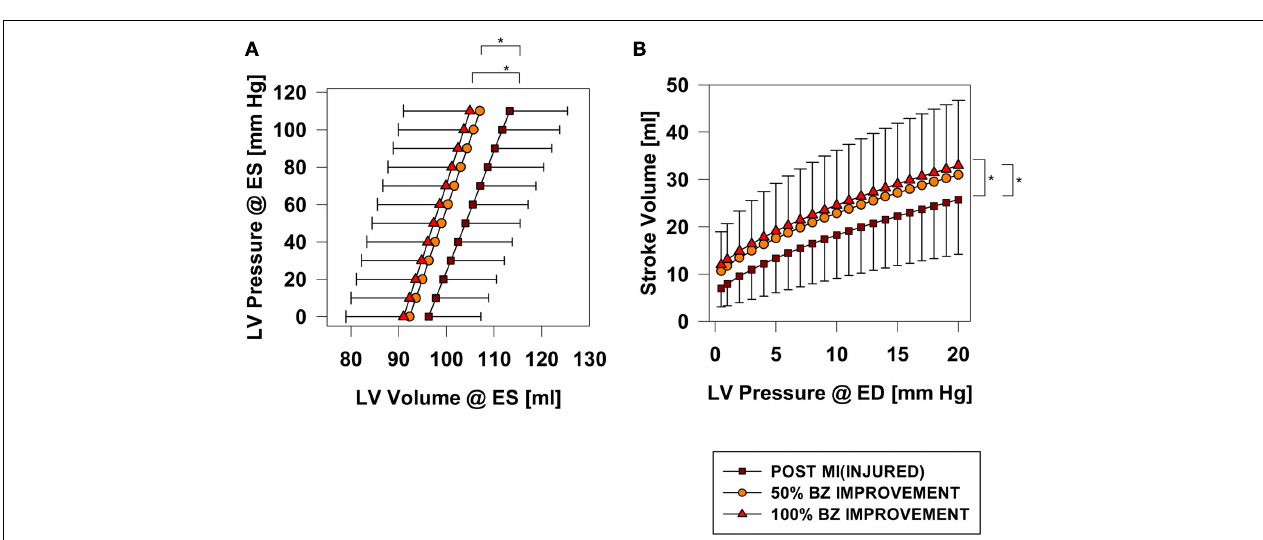
FIGURE 3 |Typical end-systole myofiber stress distribution in a sheep (corresponds to Figure 1) before (A) and after a 50% (B) and 100% (C) increase in BZ contractility. Fringe levels are in units of